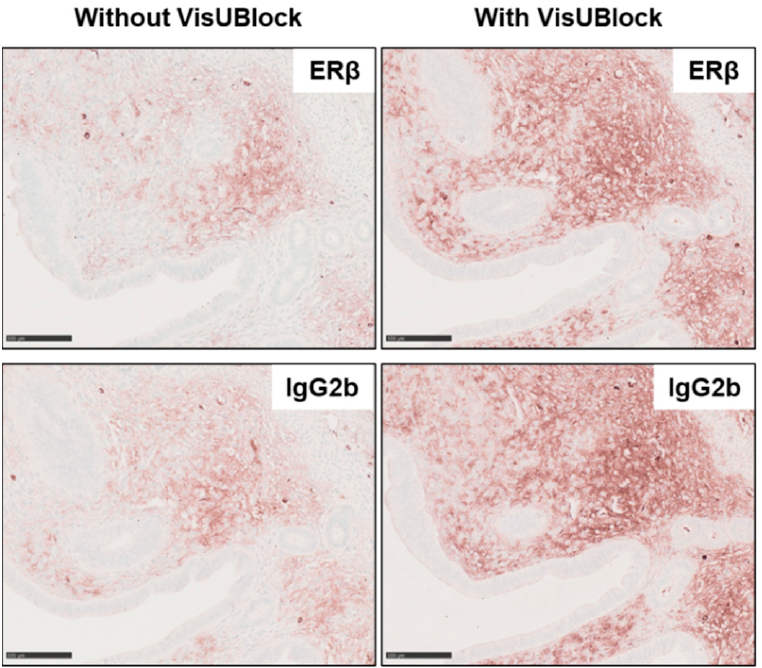
Figure 6. Effects of VisUBlock in immunohistochemical detection. Tissue slices of murine uterine tissue were prepared as described in Material and Methods including incubation for 1 hour with VisUBlock blocking reagent prior staining with PPZ0506 antibody or isotype-specific IgG 2b nega- tive control. The use of VisUBlock increased unspecific background signals in the uterine tissue. Scale bar: 100 µm (200×).